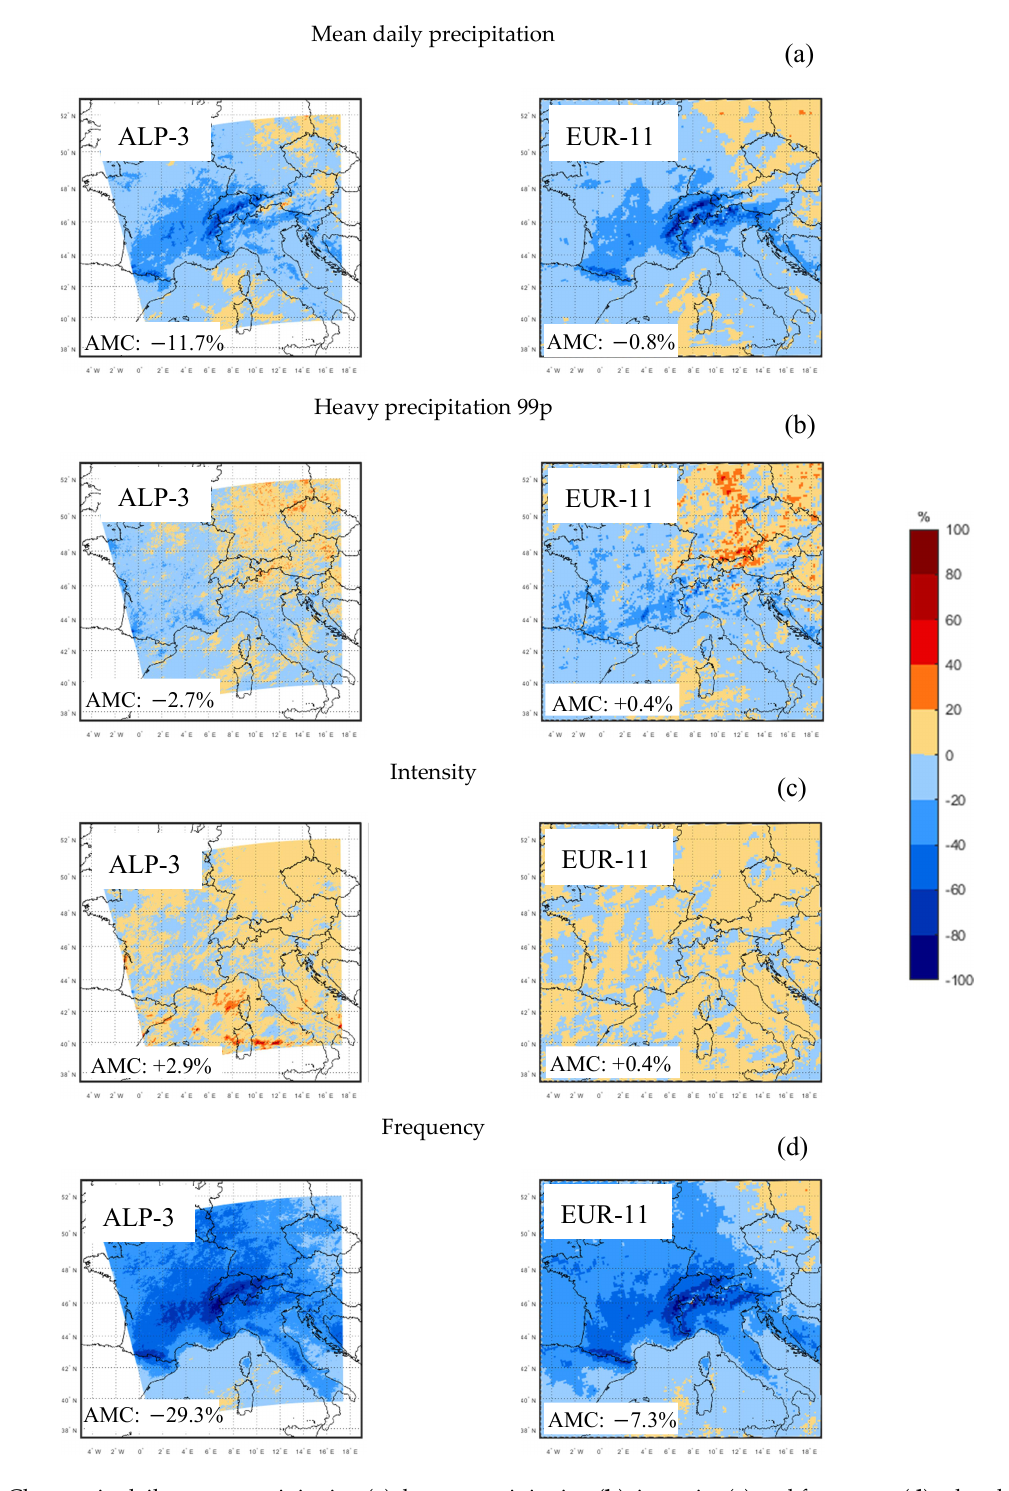
Figure 6. Changes in daily mean precipitation ( a ), heavy precipitation ( b ), intensity ( c ) and frequency ( d ) related to summer season (JJA) projected at the end of century (2090–2099) with respect to the historical period